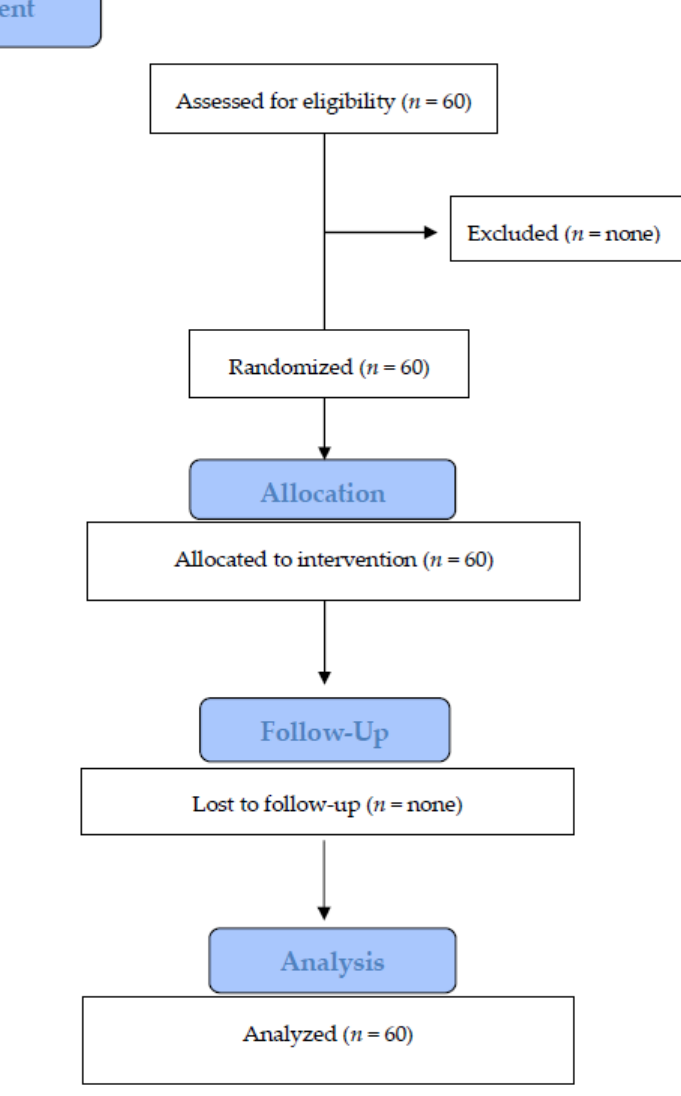
Figure 1. Flow Figure 1. Flow diagram.